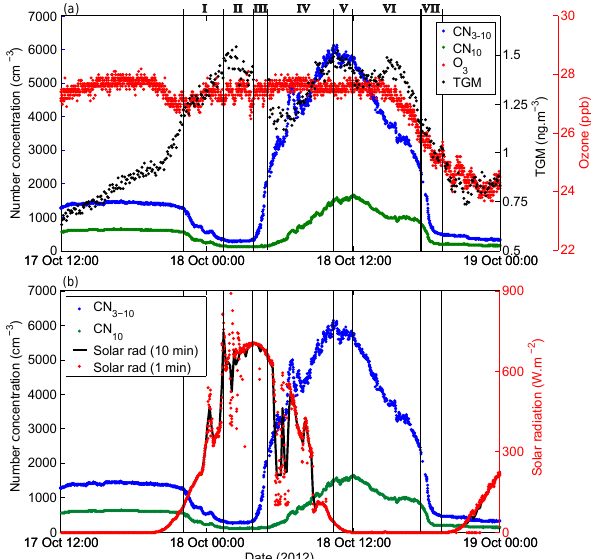
Figure 5. Close up time series showing how various other parame- ters vary relative to the particle formation event. Aerosol concentra- tions are included for reference. (a) O 3 and TGM. (b) Solar radia- tion (1 and 10min